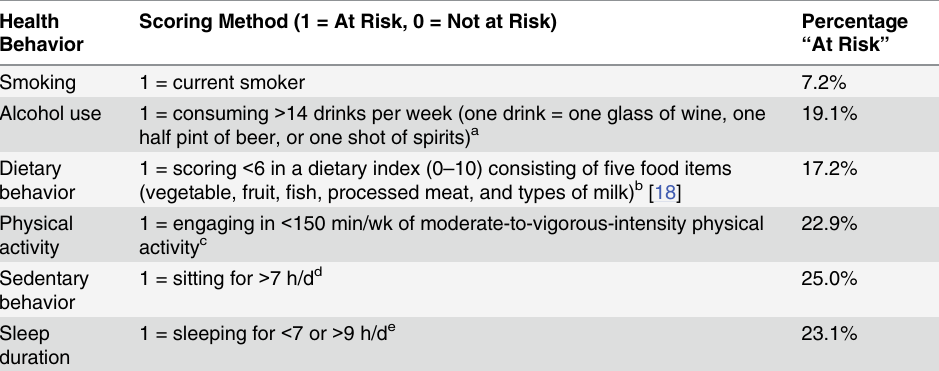
Table 1. Scoring of risk factors in the lifestyle risk index based on the 45 and Up Study. Health